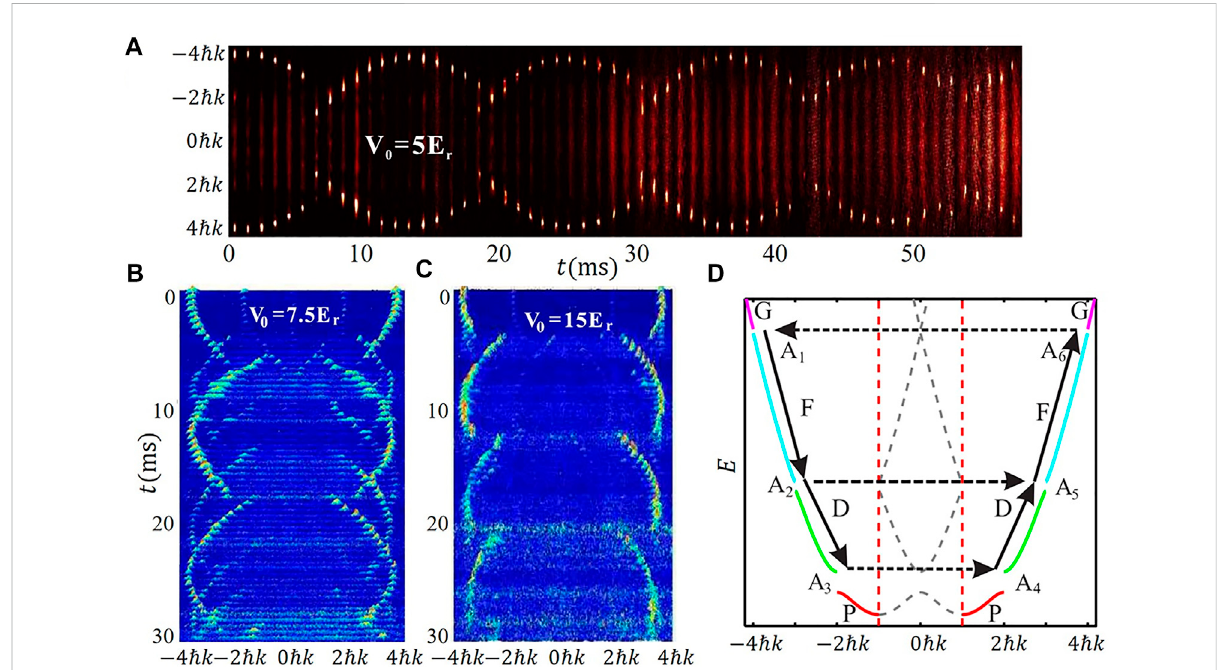
FIGURE 13 Quantum oscillations of the BECs in higher bands of the 1D optical lattice. Experimental results in momentum space with lattice depth (A) 5 E r , (B) 7.5 E r , and (C) 15 E r . (D) Schematic of extended Bloch bands of the 1D optical